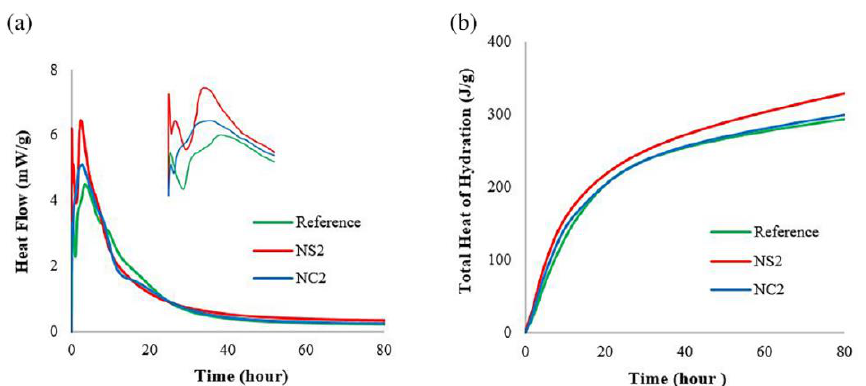
Figure 11. Hydration rate curve and cumulative heat of hydration of geopolymer slurry at 60 °C [69]. ( a ) Rate of hydration at 60 °C, ( b ) Total heat hydration at 60 °C.